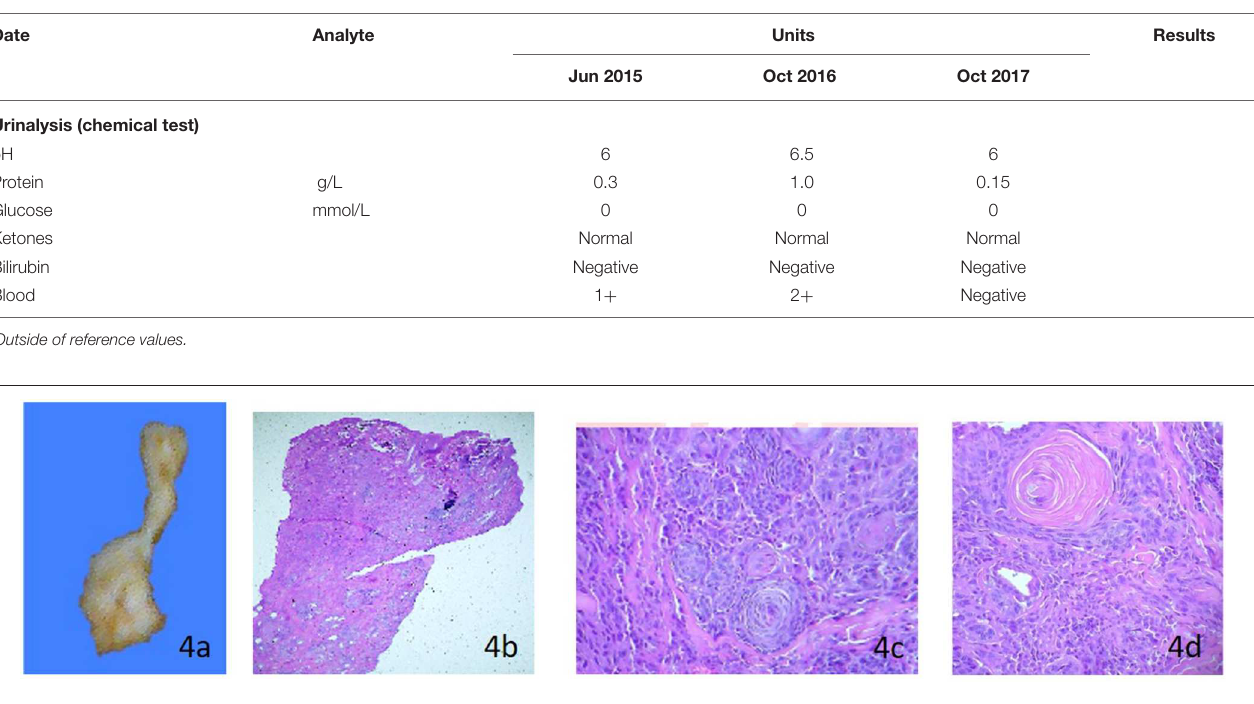
FIGURE 4 | Fistula histopathological analysis macroscopic description: (a) Left periocular skin (1.2 × 0.8cm), homogeneous white surface, broad apical end interspersed with adipose tissue, and irregular edges. Microscopic description (b) Epidermis with loss of continuity of the epithelium, partially covered by serocellular scabs. Below, poorly demarcated and infiltrating neoplastic flat stratified epithelial tissue arranged in interconnected islands and trabeculae. (c) Pleomorphic cells with hypereosinophilic cytoplasm with small vacuoles; one or two prominent, pleomorphic nuclei with fine granular chromatin; 7 atypical mitoses/10 randomized fields (400X), anisocytosis and anisokaryosis. (d) Marked desmoplasia, and some nests, the neoplastic cells (also present in surgical border) are organized around concentric sheets of keratin (keratin beads). Diagnosis- Squamous cell carcinoma well-differentiated proliferative cells, generalized moderate ulcerative